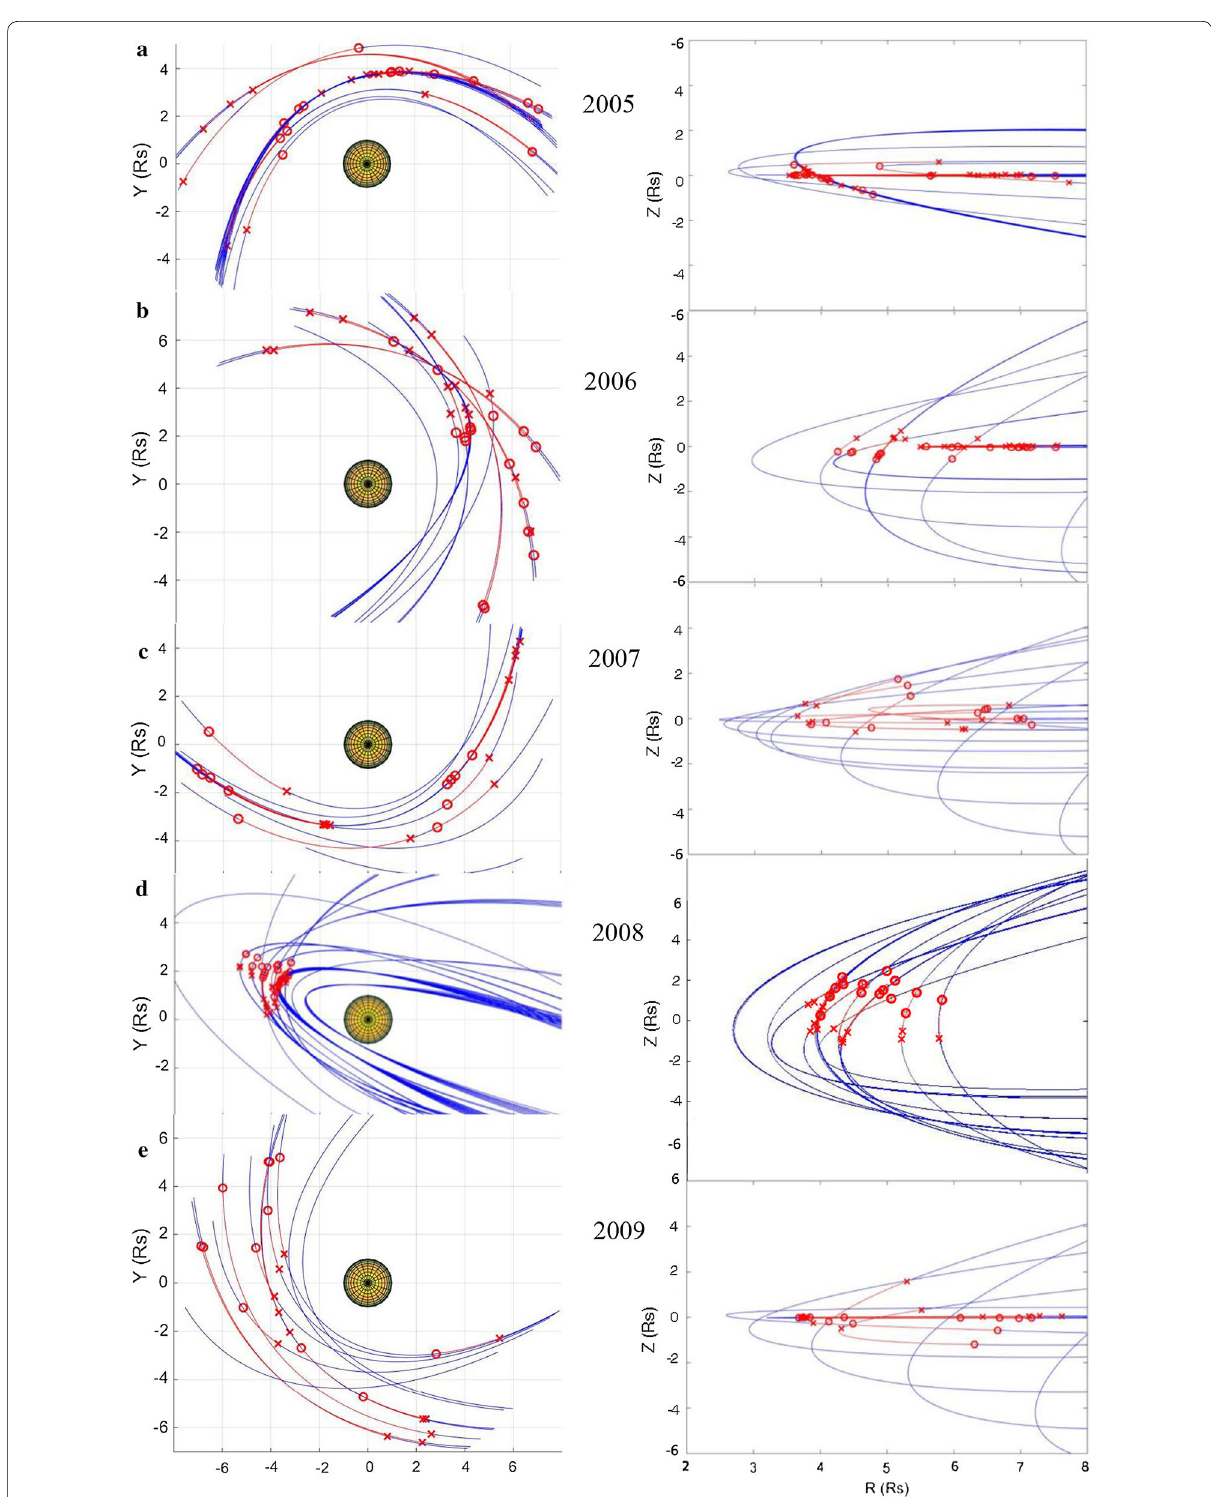
Fig. 1 a Cassini orbit projection in the X – Y equatorial plane, in a Saturn-centered coordinate system. b Cassini orbit projection in the cylindrical R – Z plane. The positive X -axis is pointing toward noon time. The orbit curves are in red when the wave frequencies are near to the local water-group ion